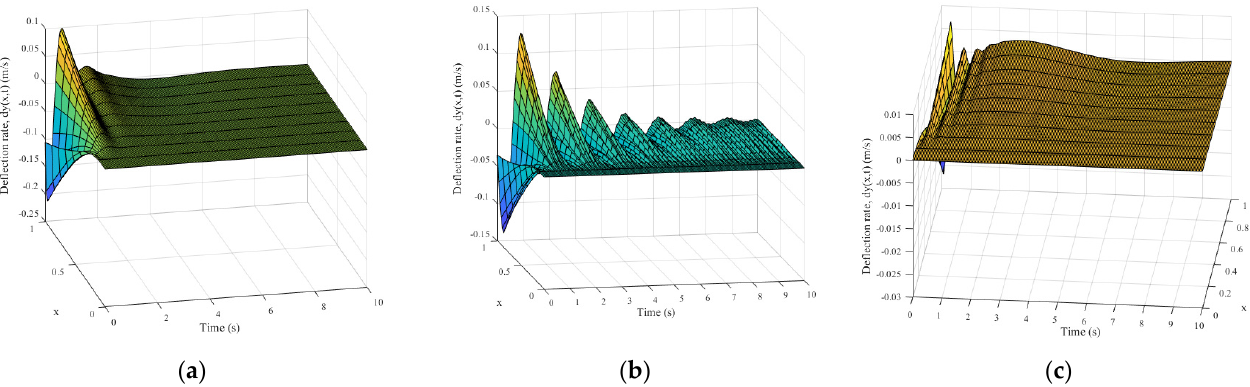
Figure 6. The deformation rate results of different methods: ( a ) adaptive boundary method; ( b ) RBF neural network method; ( c ) the proposed method.